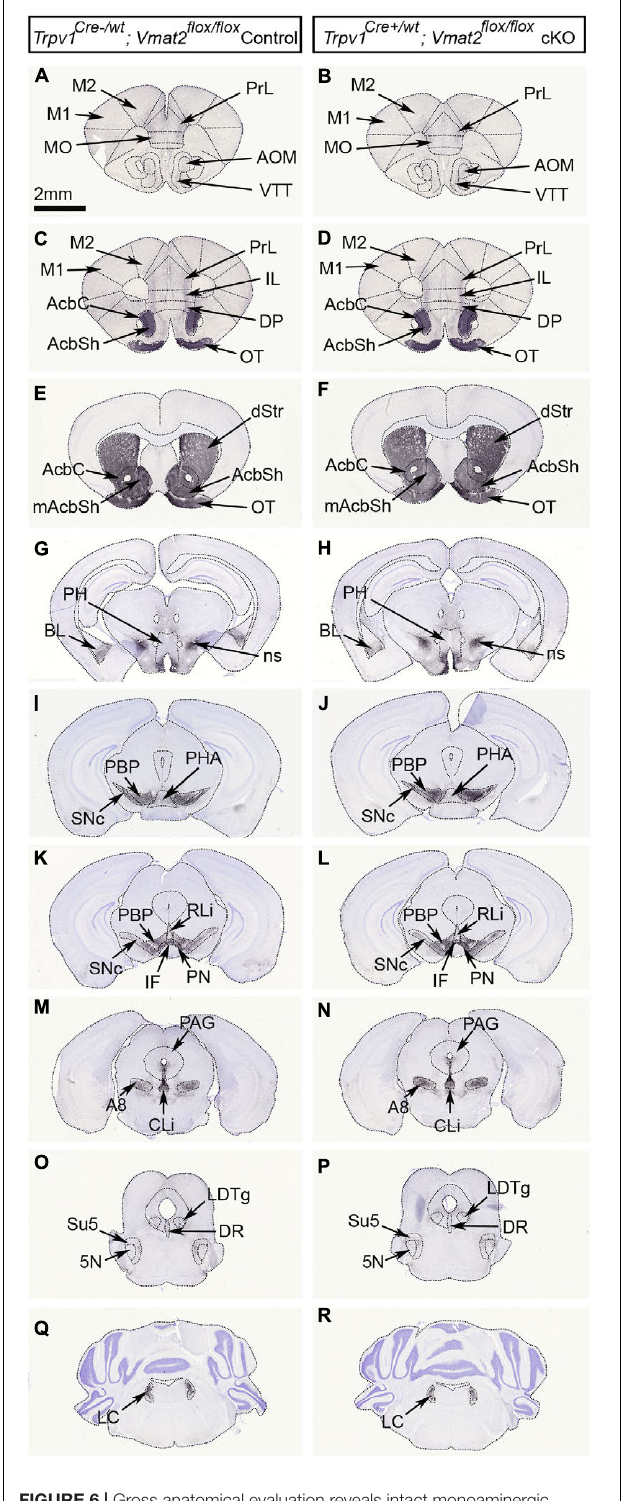
FIGURE 6 | Gross anatomical evaluation reveals intact monoaminergic neurons in TrpV1 Cre + / wt ;Vmat2 flox / flox cKO mice. Analysis of age-matched TrpV1 Cre − / wt ;Vmat2 flox / flox control and TrpV1 Cre + / wt ;Vmat2 flox / flox cKO adult mice (24 weeks). Coronal serial brain sections showing the distribution of